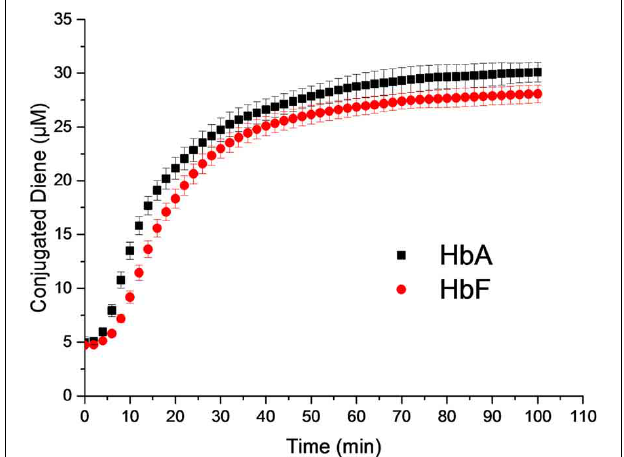
FIGURE 5 | Liposome oxidation by Hb. Conjugated diene formation over time was measured at 234nm.